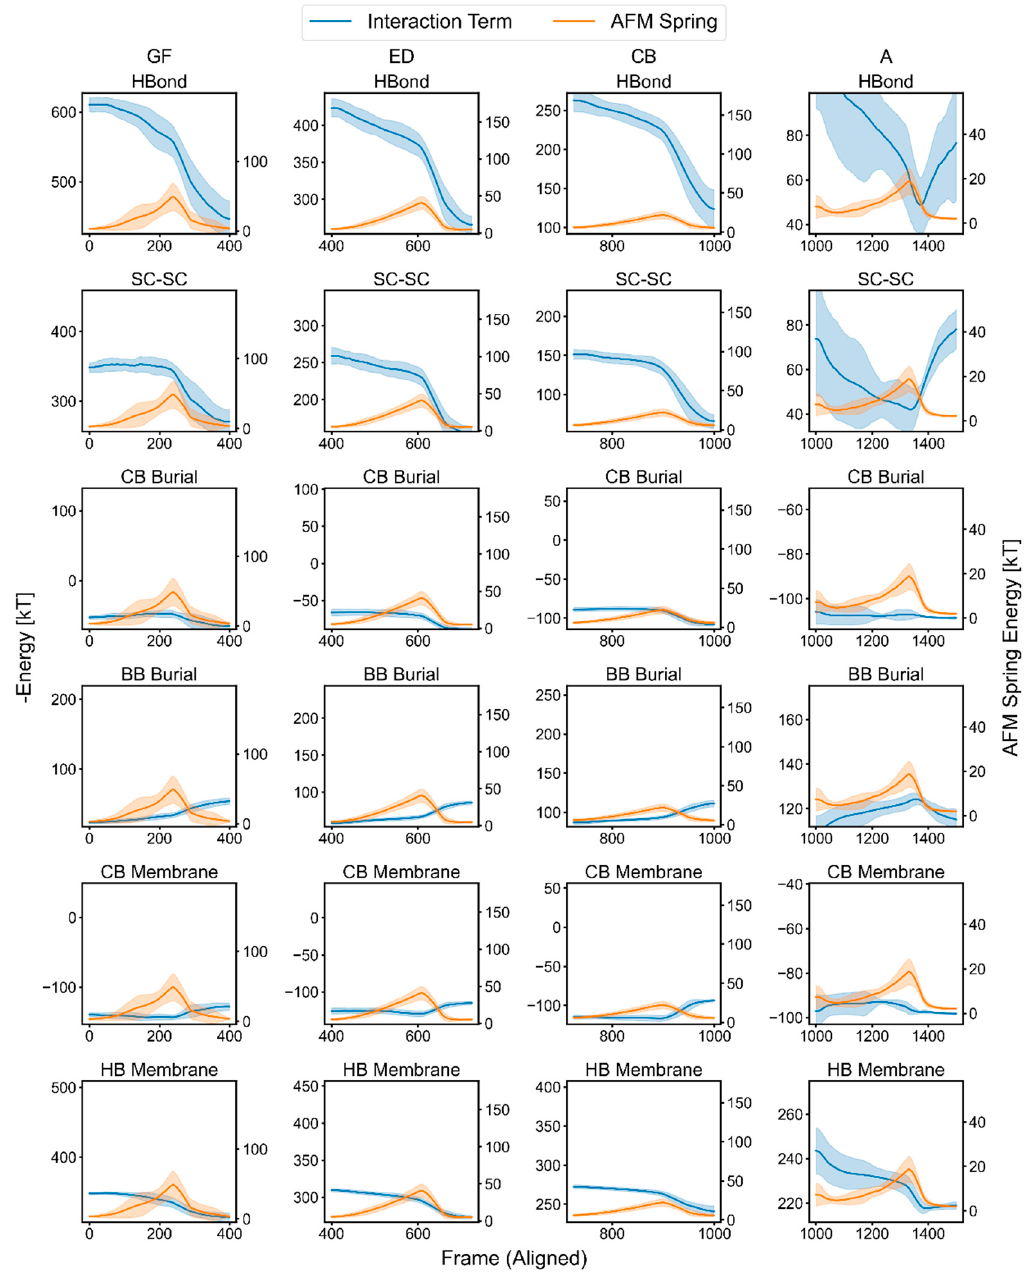
Figure 5. Averaged responses of interaction terms and AFM spring energy during pulling on bR . The blue plots are the negatives of the interaction terms (left y-axis), and the orange plots are the AFM spring energies (right y-axis). The solid lines represent the averages of 28 replicas after smoothing each replica and aligning the maximum spring energy for each rupture event, and the width is the standard deviation. The non-HB terms are further separated into SC–SC (pairwise side-chain interactions) and multibody desolvation terms related to C β and backbone burial. The membrane potential is further separated into CB Membrane (implicit membrane interaction experienced via C β ) and HB Membrane (perturbation to H bonding in the membrane)